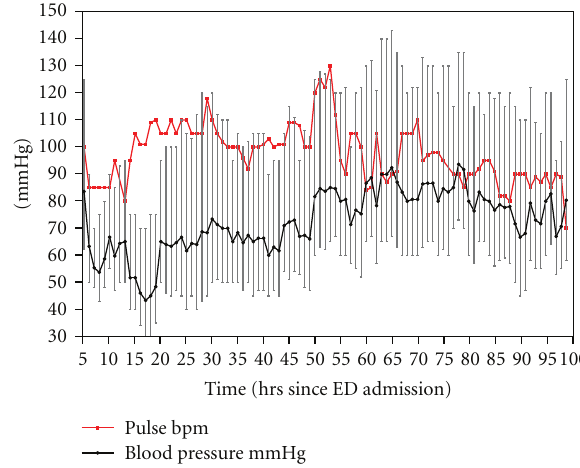
Figure 1: Haemodynamic parameters over the intensive care period.